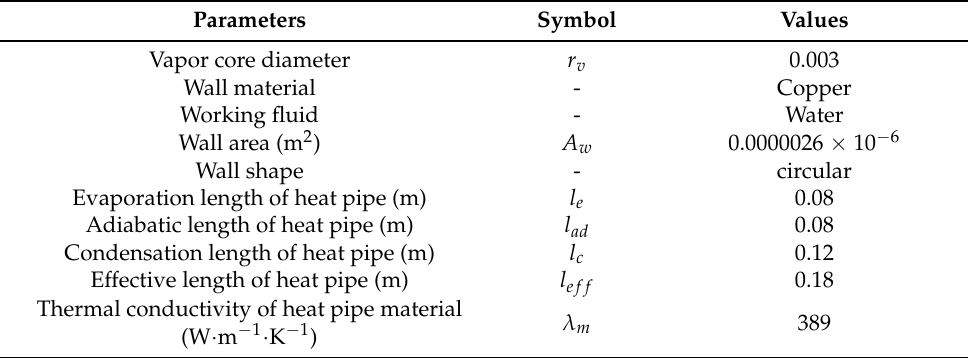
Table 3. Heat pipe design parameters